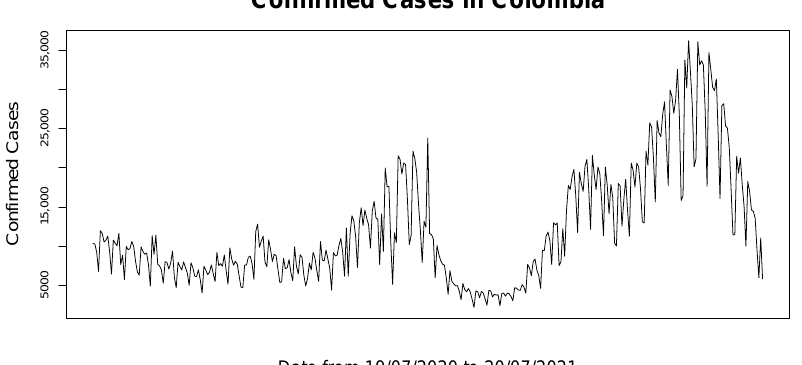
Figure 1. Two waves of contagion by COVID-19 between the dates 19 July 2021 and 20 July